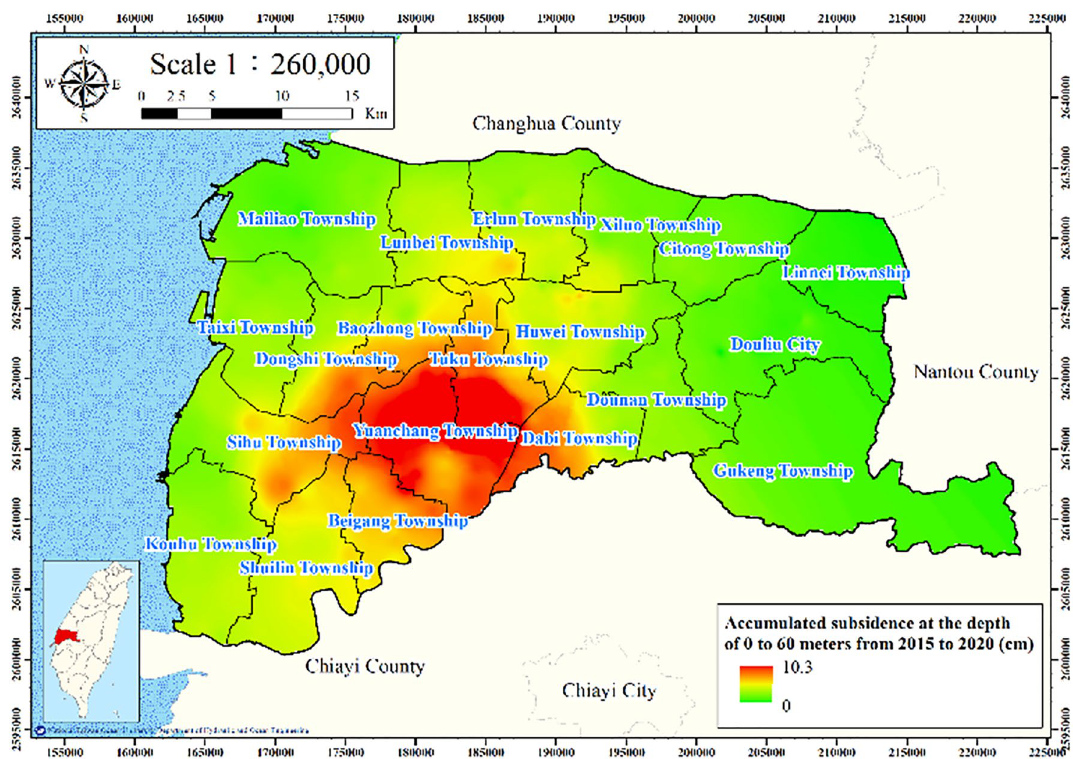
Figure 8. Accumulated subsidence from 2015 to 2020 at 0–60 m. This figure was created using ArcGIS 10.6.1